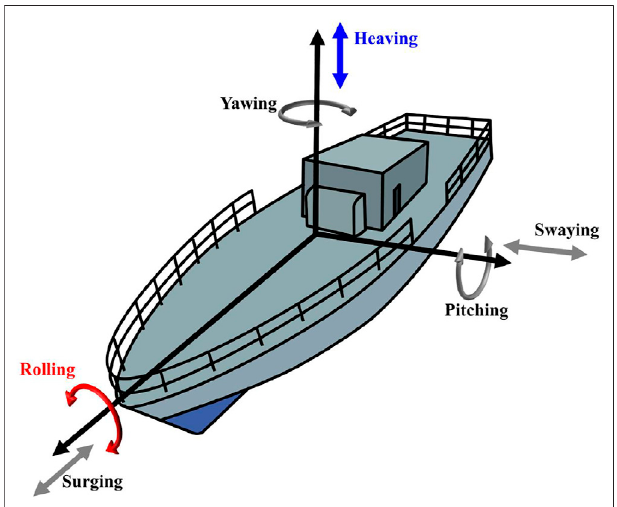
FIGURE 1 | Six degrees of freedom about marine